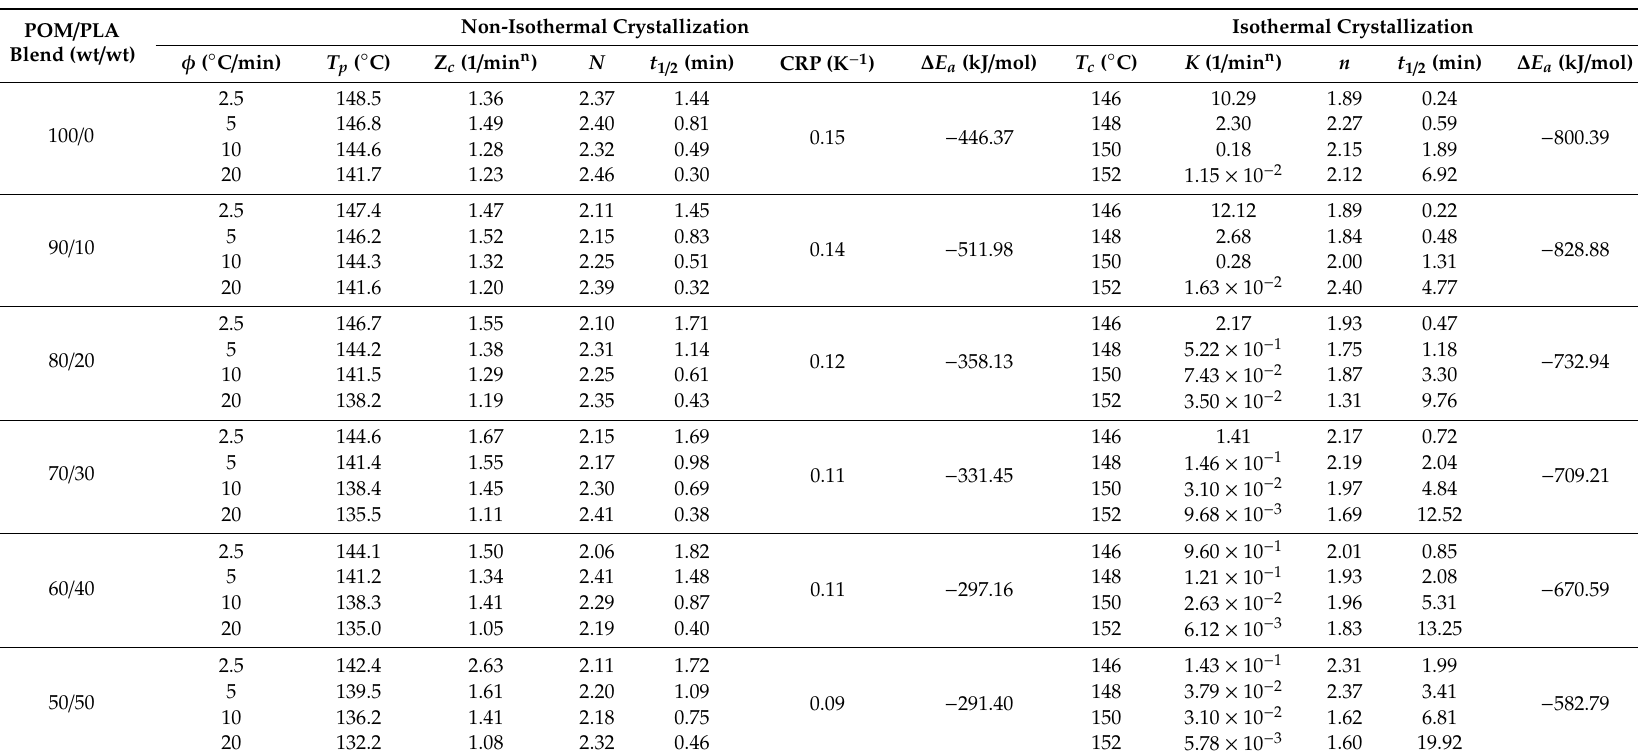
Table 1. The crystallization kinetic parameters of pure POM and its blends with PLA under the non-isothermal and isothermal conditions. POM /